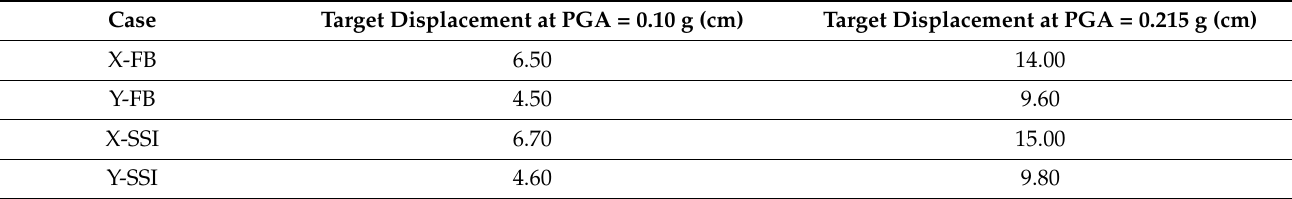
Table 10. Target displacements at a PGA level of 0.10 g and 0.215